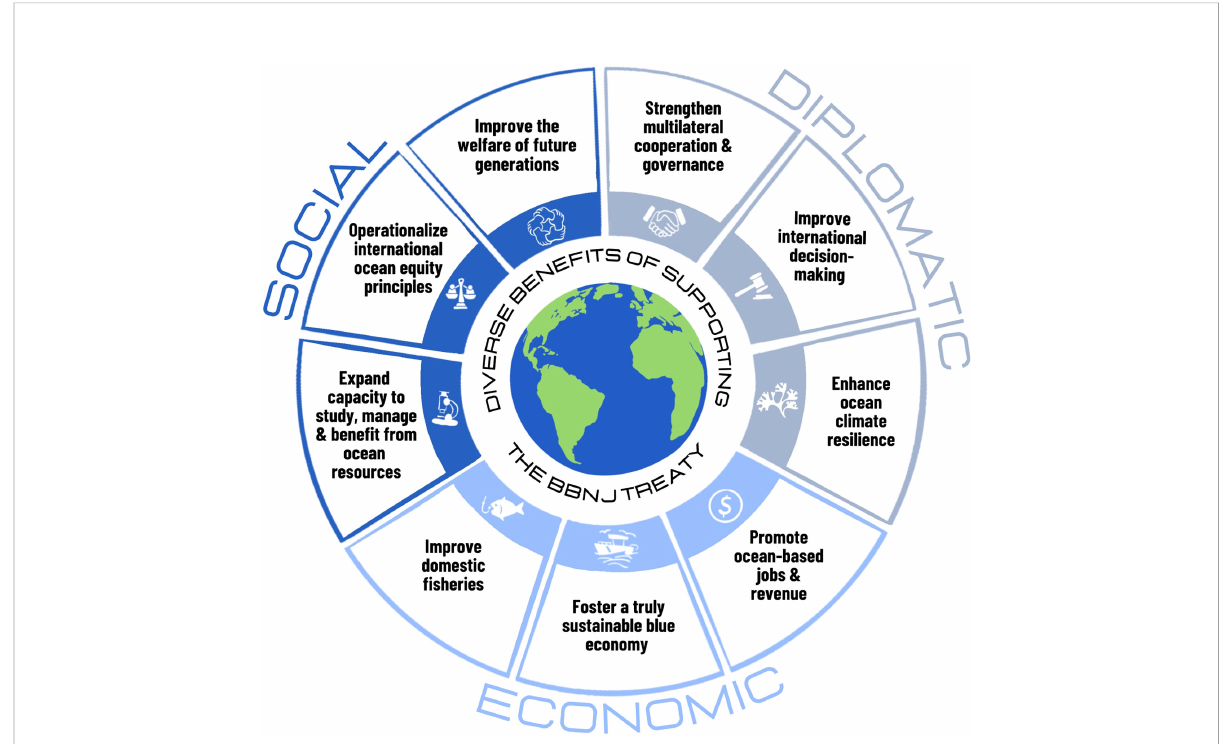
FIGURE 1 Diplomatic, economic, and social bene fi ts for strengthening and supporting the marine biological diversity of areas beyond national jurisdiction (BBNJ) intergovernmental